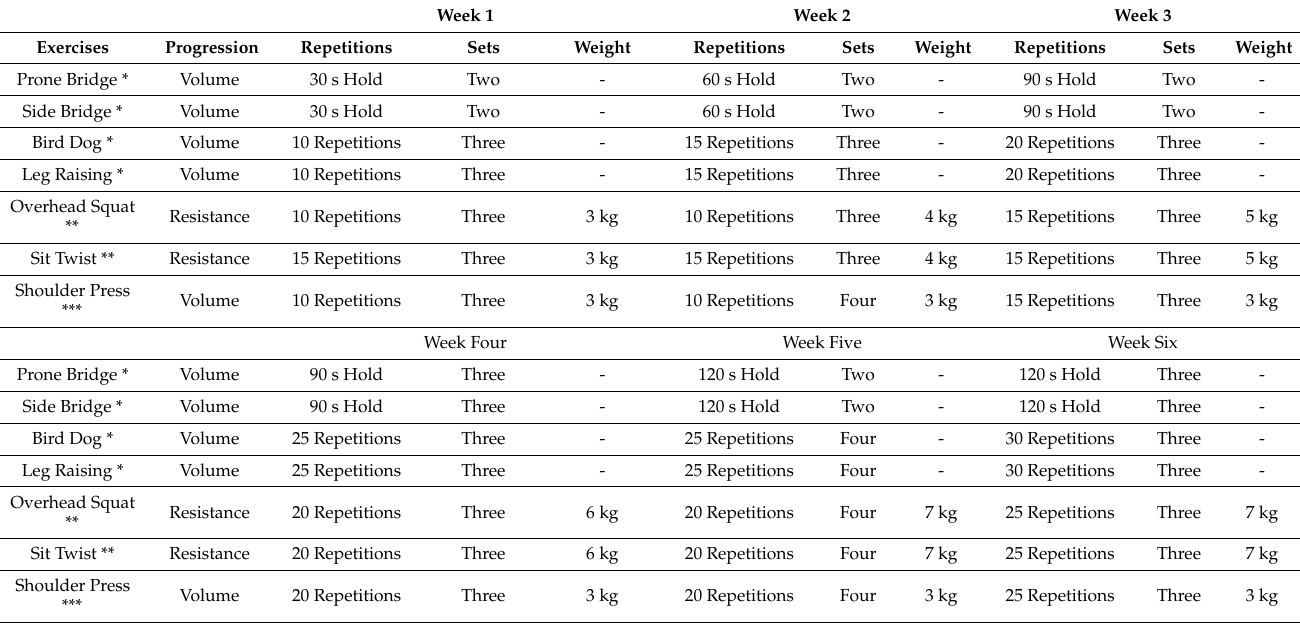
Table 1. Core training program for the